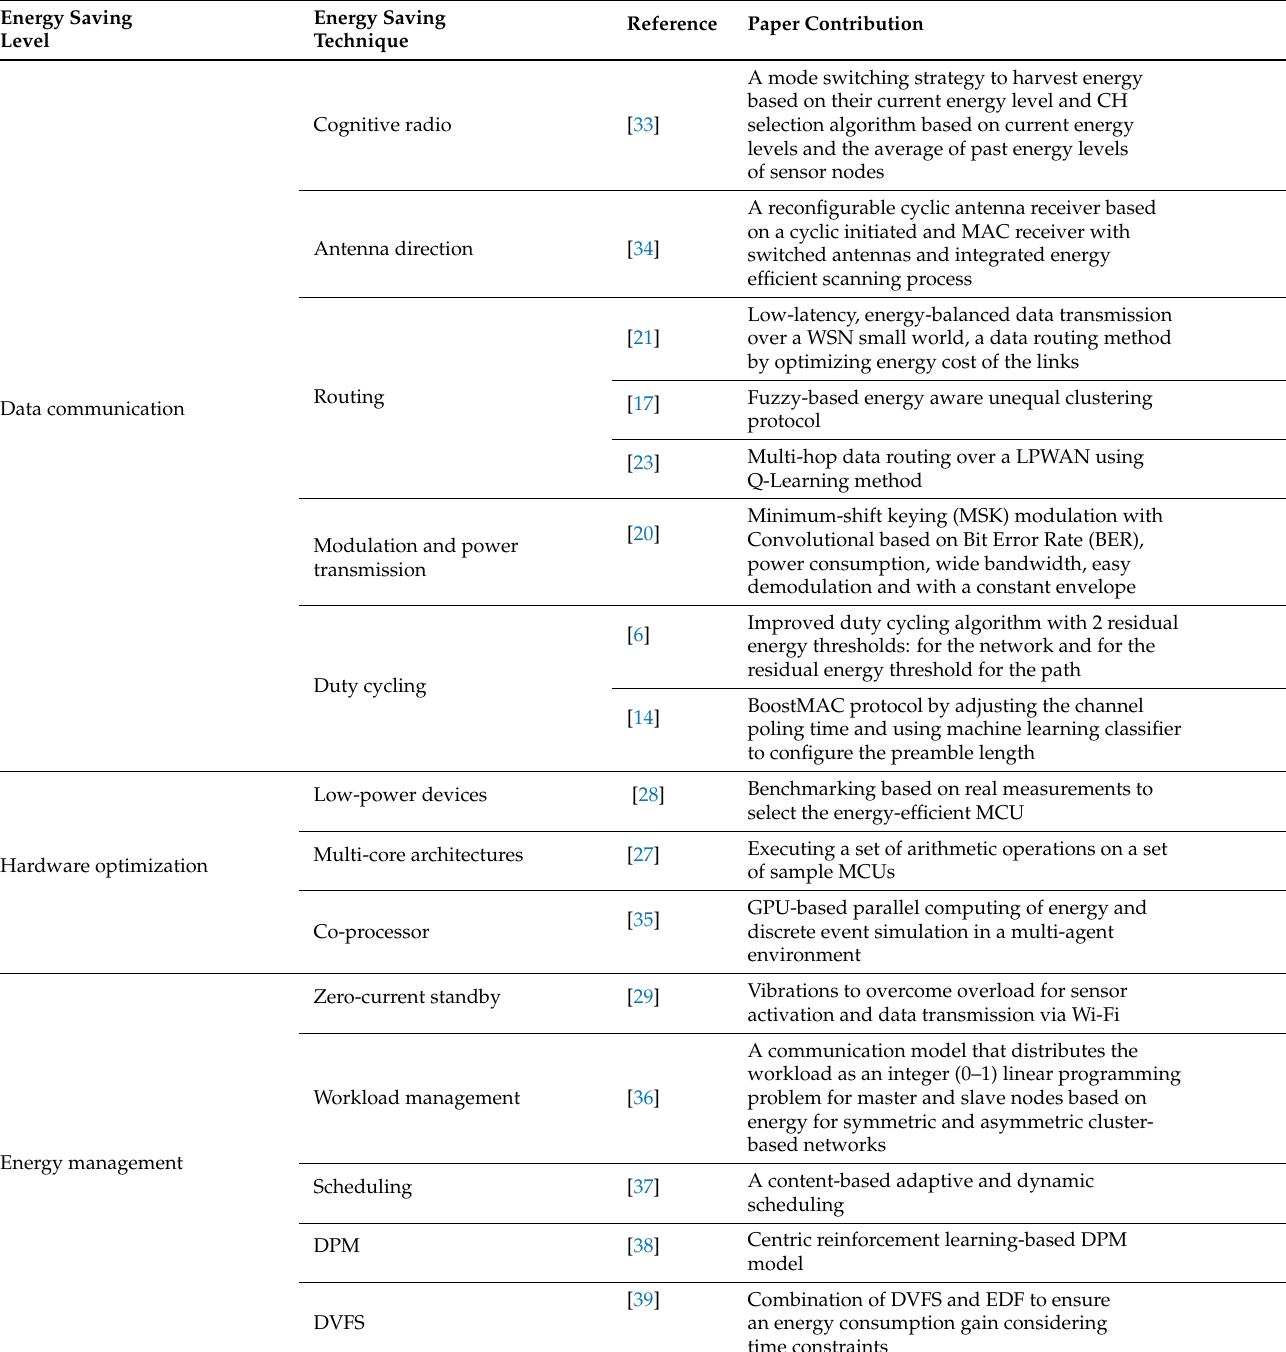
Table 1. Comparative study of existing works related to energy saving techniques in